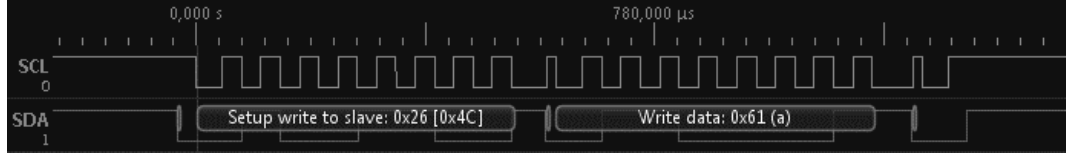
Figure 25. Clock line and data line of a sample acquisition request to a probe with the 0 × 26 address.